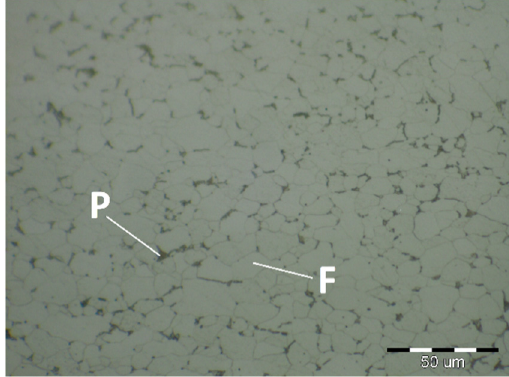
Figure 8. Base material microstructure—ferritic-pearlitic (HSLA).